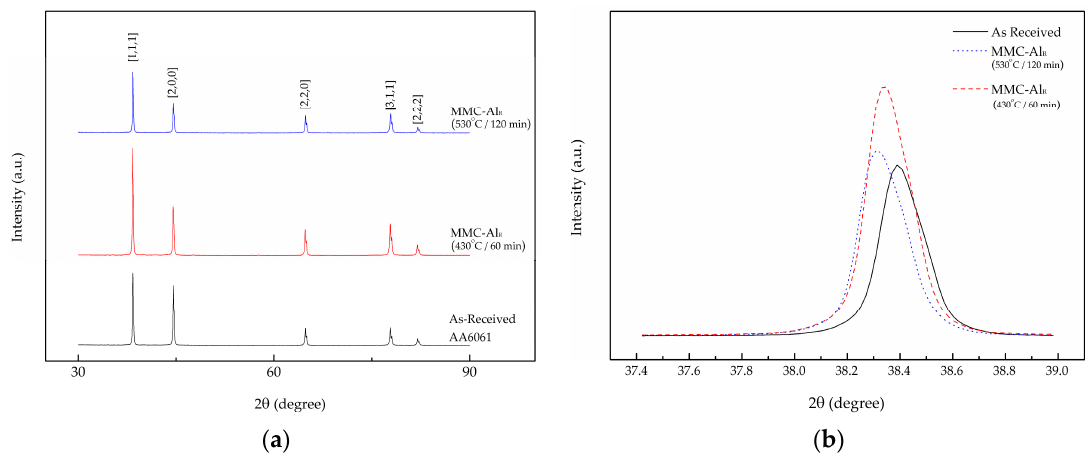
Figure 4. X-ray diffraction (XRD) pattern for as-received (AR) and metal matrix composite (MMC-Al R ) at minimum and maximum parameter settings for the ( a ) whole spectra and ( b ) peak (1,1,1). Table 6. Crystallite size of samples at peak (1,1,1).